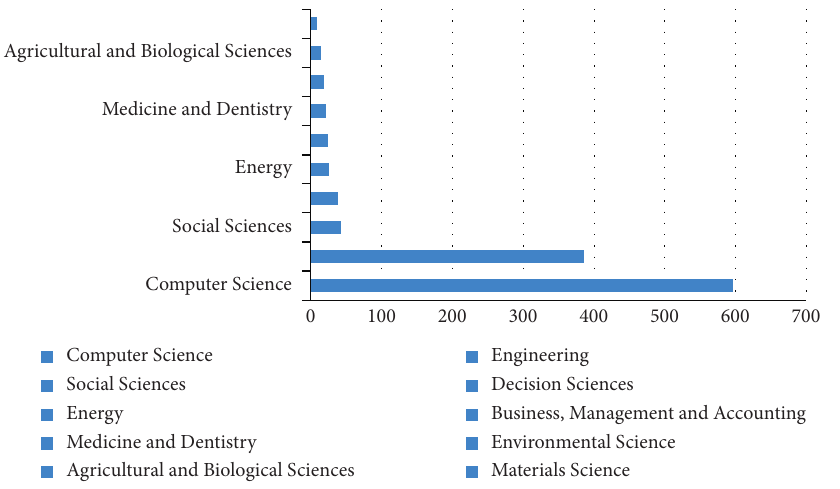
Figure 12: Subject areas and